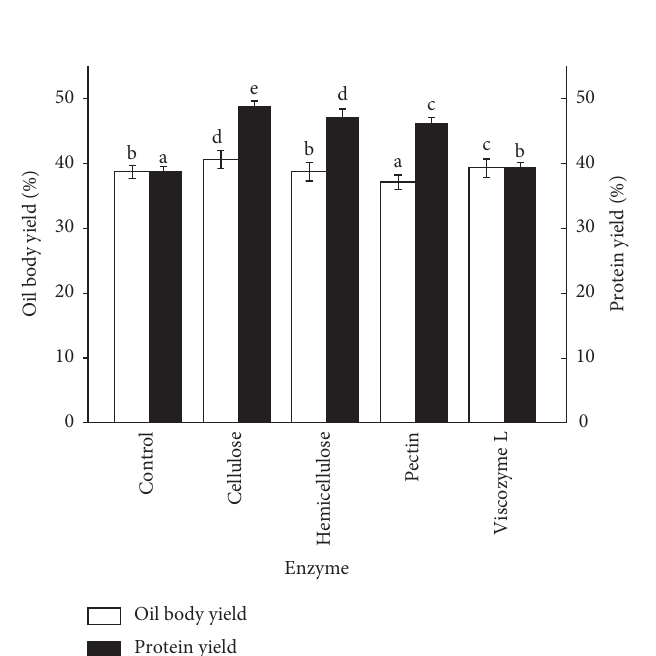
Figure 1: Effects of different cell wall-degrading enzymes on the yields of peanut oil body and aqueous phase